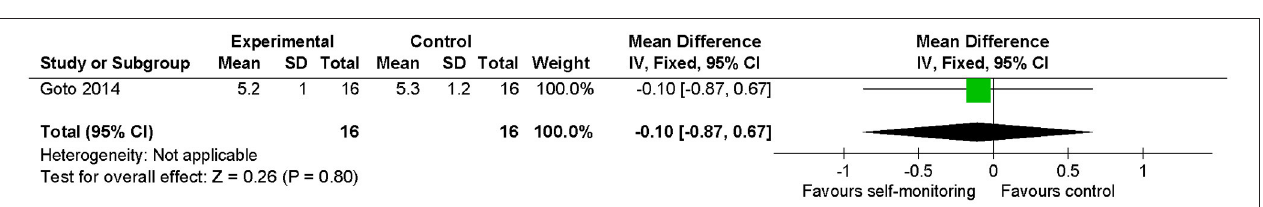
FIGURE 8 | Comparison of walking ability in patients with hemophilia. Gait speed (timed 10-m walk, s) post-intervention. SD, standard deviation; IV, inverse variance method; CI, confidence